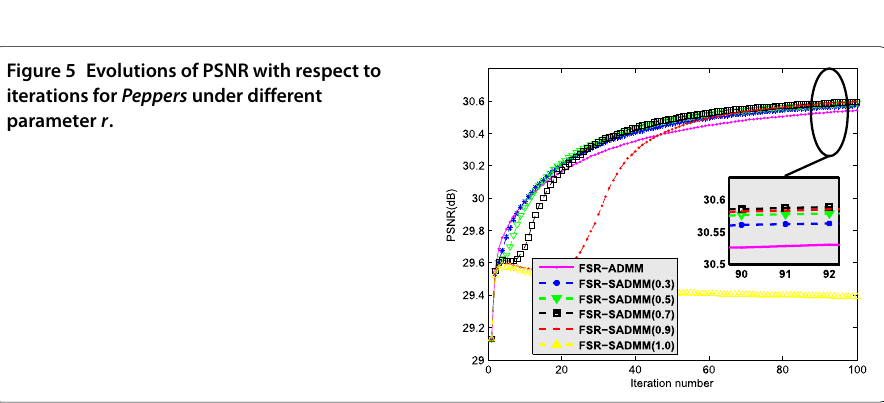
Figure 5 Evolutions of PSNR with respect to iterations for Peppers under different parameter r .